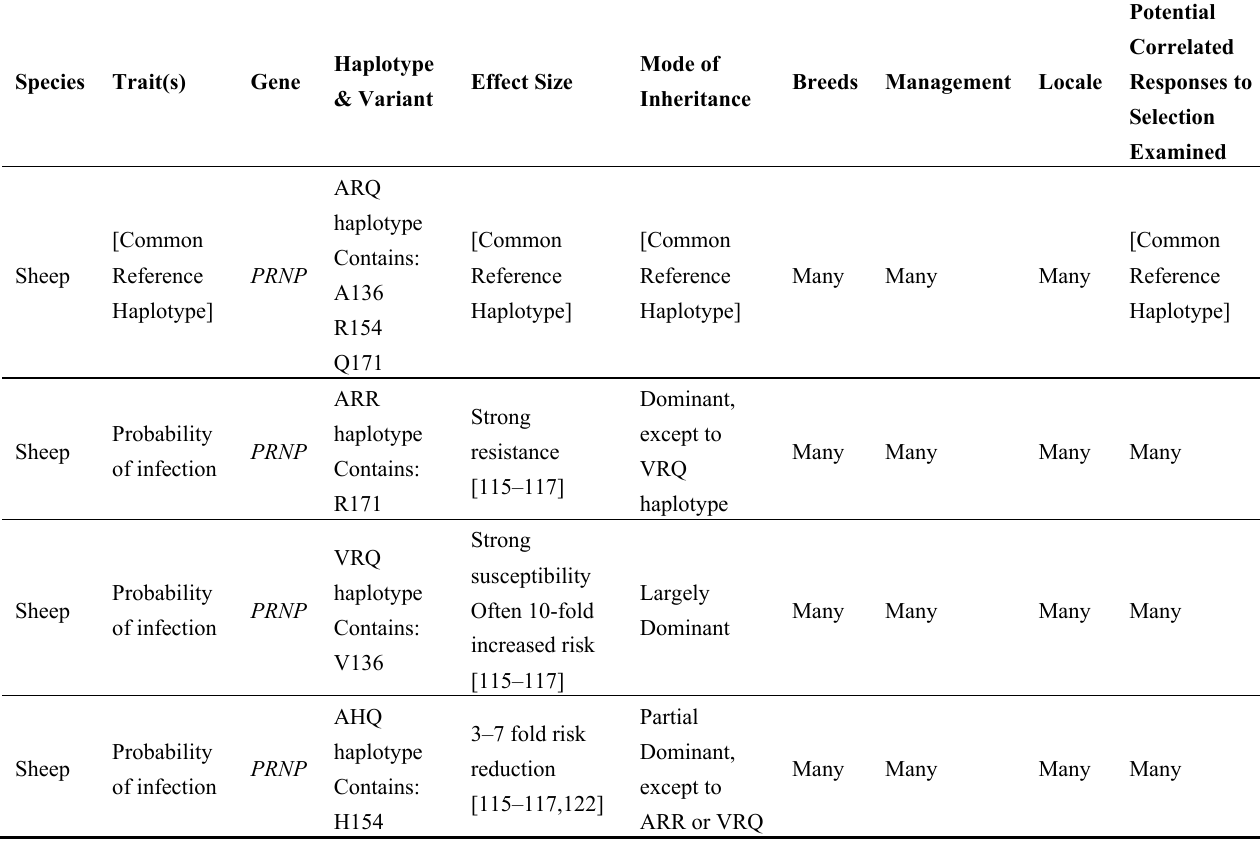
Table 2. Example genetic markers for infectious disease in sheep: Classical